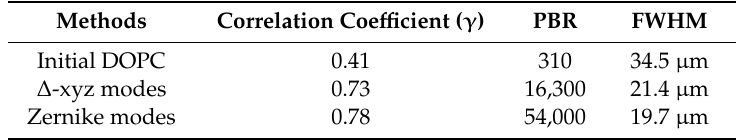
Figure 4. Experimental results of the automatic optimized method for DOPC in focusing through scattering media. ( a ) Focus pattern without DOPC compensation; ( b ) Zernike coefficients of the Zernike compensation phase in this experiment, searched via the MPGA; ( c ) line profiles of the central row of focal spots in initial DOPC, in Δ -xyz modes, and in Zernike modes; ( d ) initial DOPC focus pattern before the MPGA optimization process; ( e ) DOPC focus in Δ -xyz modes with the MPGA optimization process; ( f ) DOPC focus pattern in Zernike modes with the MPGA optimization process; ( g ) initial conjugate compensation phase pattern of the scattering field; ( h ) conjugate compensation phase pattern in Δ -xyz modes with the MPGA optimization process; ( i ) conjugate compensation phase pattern in Zernike modes with the MPGA optimization process. Table 1. Comparison of optimization abilities under three